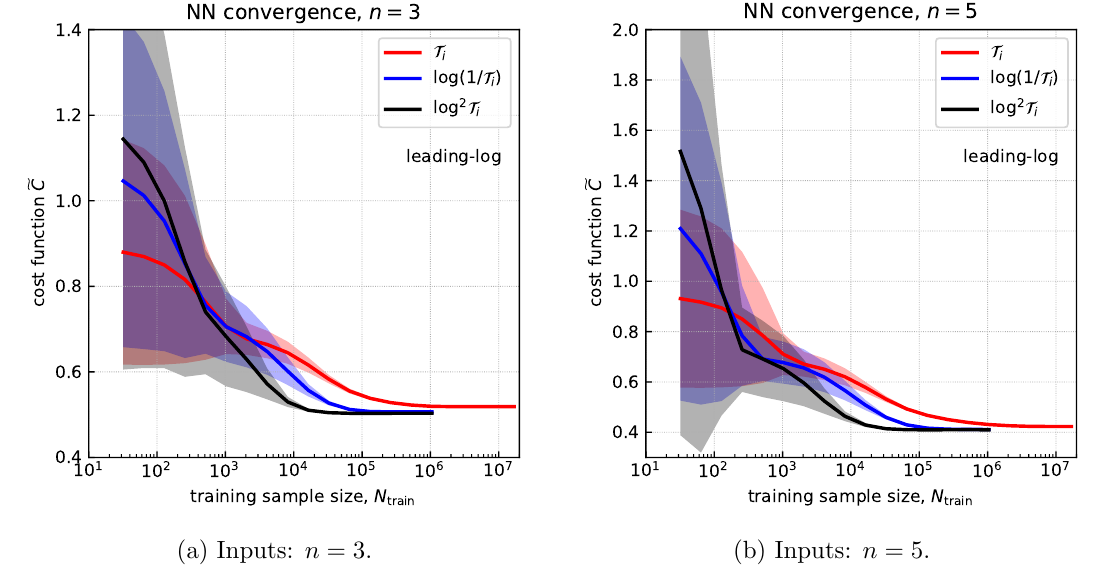
Figure 4 . Convergence of the network as a function of the training sample